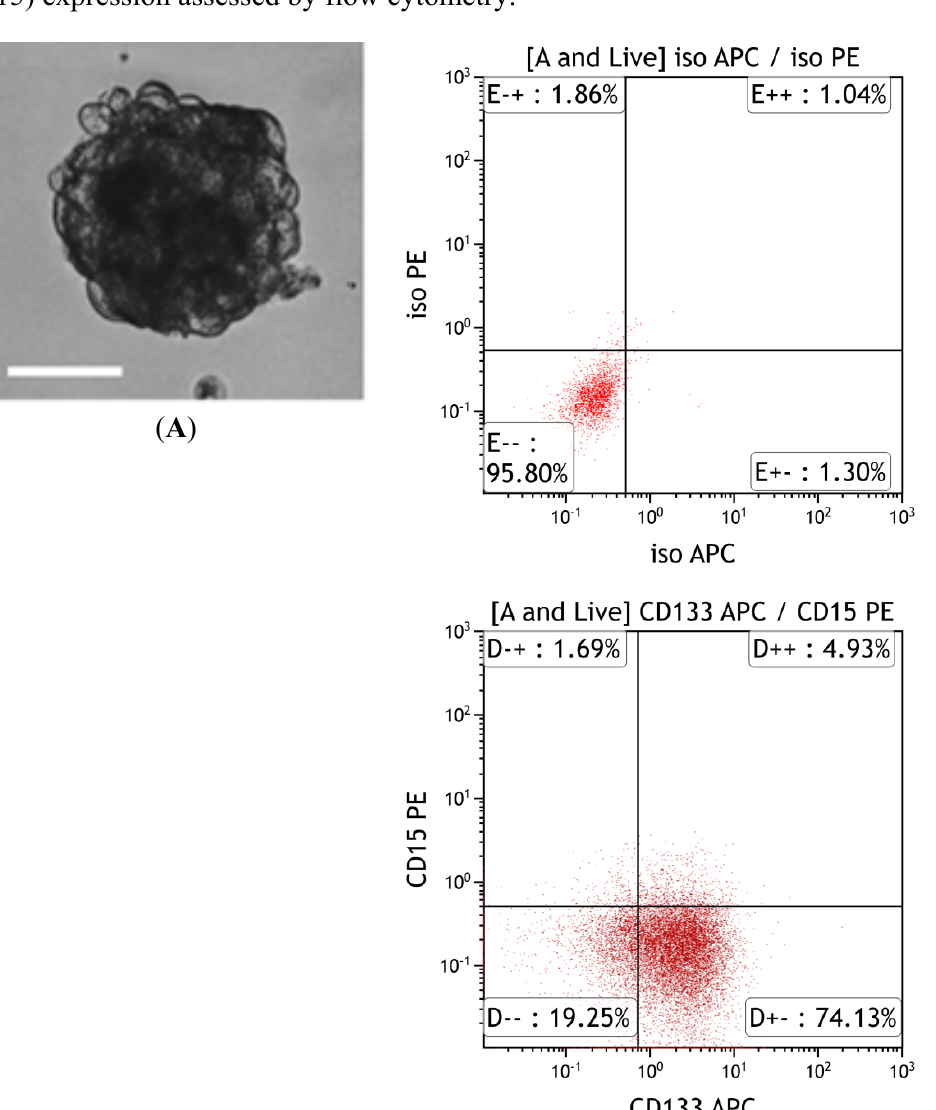
Figure 2. Characteristics of brain metastasis-initiating cells. ( A ) BM from the lung possess a cancer stem cells (CSCs) in vitro (100× magnification, 100 µm). Patient-derived BM samples were grown as tumorspheres in neural stem cell media; ( B ) CSC marker ( i.e. ,